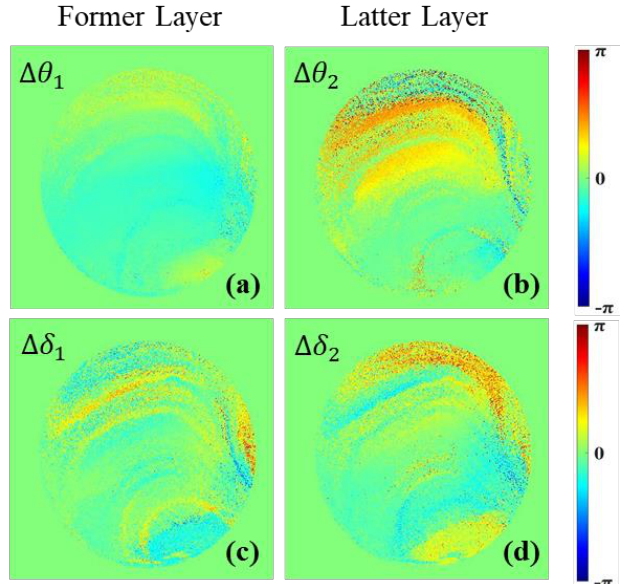
Figure 7. Two-layered difference of retardance parameters ∆ θ 1 , ∆ θ 2 , ∆ δ 1 , ∆ δ 2 . ( a ) ∆ θ 1 image; ( b ) ∆ θ 2 image; ( c ) ∆ δ 1 image; ( d ) ∆ δ 2 image.